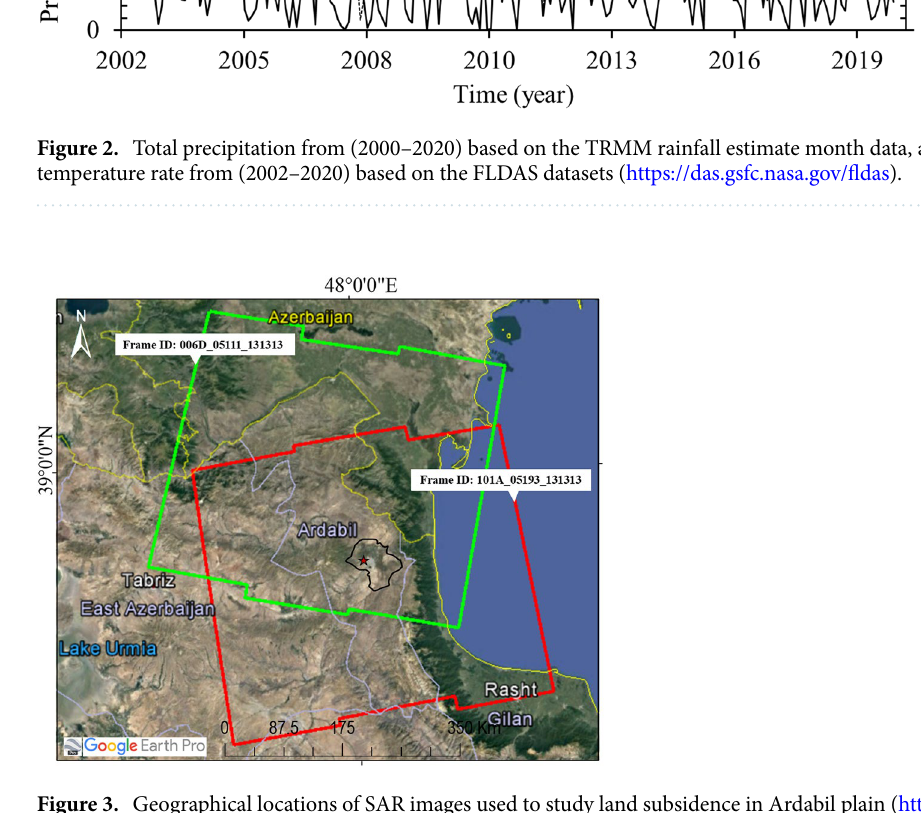
Figure 3. Geographical locations of SAR images used to study land subsidence in Ardabil plain (https:// comet. nerc. ac. uk/ COMET- LiCS- portal/). This figure was created using the Google Earth/Pro version 7.3.4.8573 software (https:// earth. google.